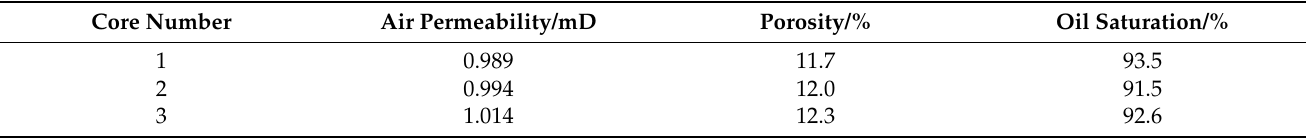
Table A2. Parameters of the three